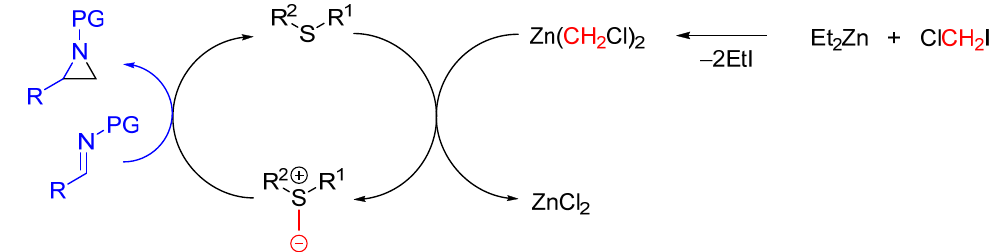
Aggarwal and co-workers further explored ylide generation by the reaction of a metallocarbene with a sulfide. They used Simmons–Smith carbenoids as a source of the metallocarbene, which on reaction with a sulfide generated sulfonium ylide in situ (Scheme 28) [88]. The ylides, generated through reaction of Simmons–Smith carbenoids and sulfides, underwent terminal aziridination with various imines derived from aromatic and aliphatic aldehydes in high yields (Scheme 29) (Table 8). Interestingly, the usual requirement in ylide aziridination for an activating electron-withdrawing group on the imine nitrogen was not found to be essential, provided the N -substituent had at least one possible coordinating site. It was postulated that these imines were activated through chelation with zinc(II) species. The authors’ effort to induce enantioselectivity with this method was not very successful. Using C 2 -symmetric chiral sulfide 14 , the best enantiomeric excess observed was only 19% (Scheme 30) [89].